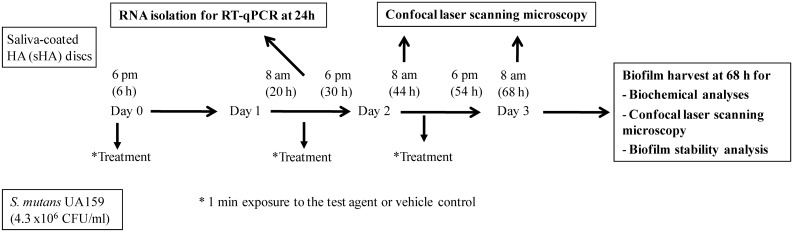
The experimental design for the treatment and analysis of biofilms of S. mutans.
The clinical conditions of typical exposure of exogenously introduced therapeutic agents in the mouth were simulated by applying the test agent twice daily for brief exposures (60 s) at early/initial formation of the biofilm (6 h). Subsequently, the biofilms were treated twice at 8 am (20 h-old) and 6 pm (30 h-old) with two more additional treatments the following day (8 am; 44 h-old and 6 pm; 54 h-old).